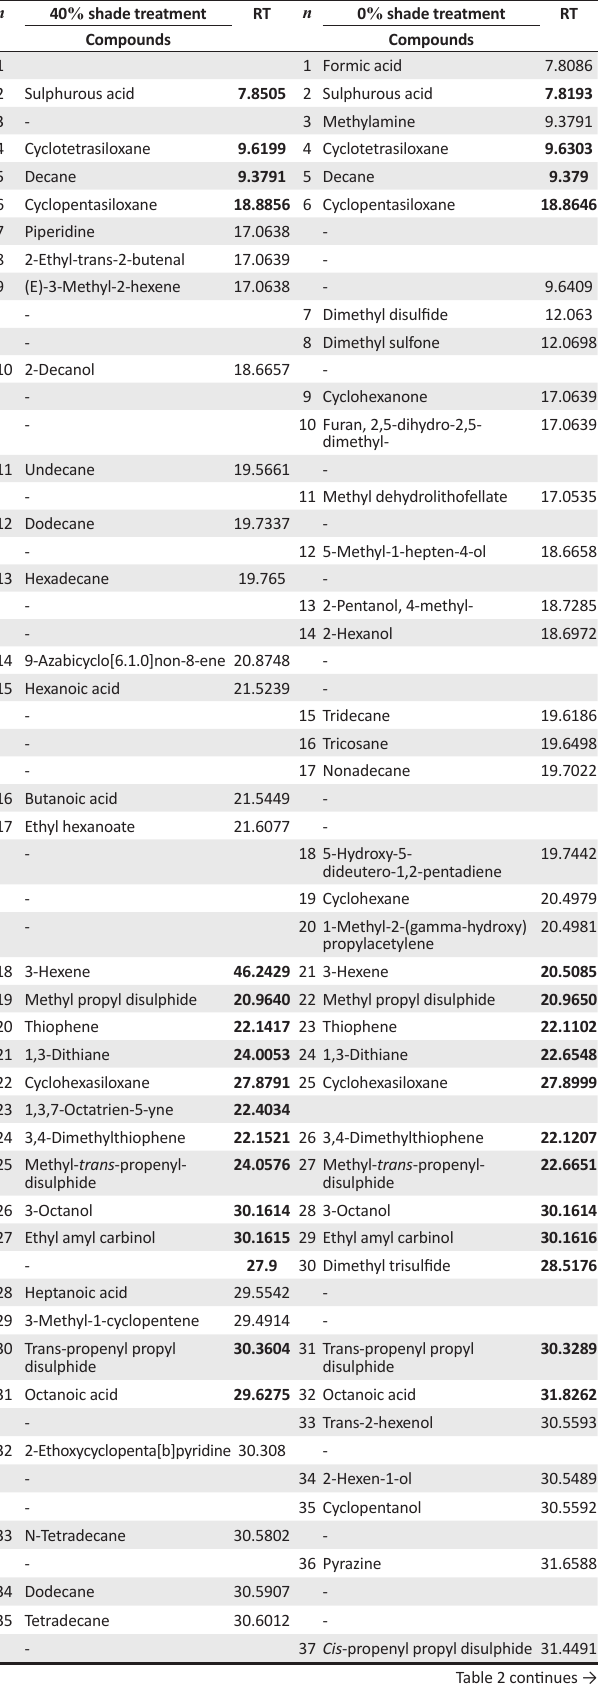
TABLE 2 (Continues...): Volatile compounds, with a mass spectral library match of at least 50 % , present in aerial parts (leaf and bulb) of leek plants ( Allium porrum ) exposed to 40 % shade and 0 % shade for 12